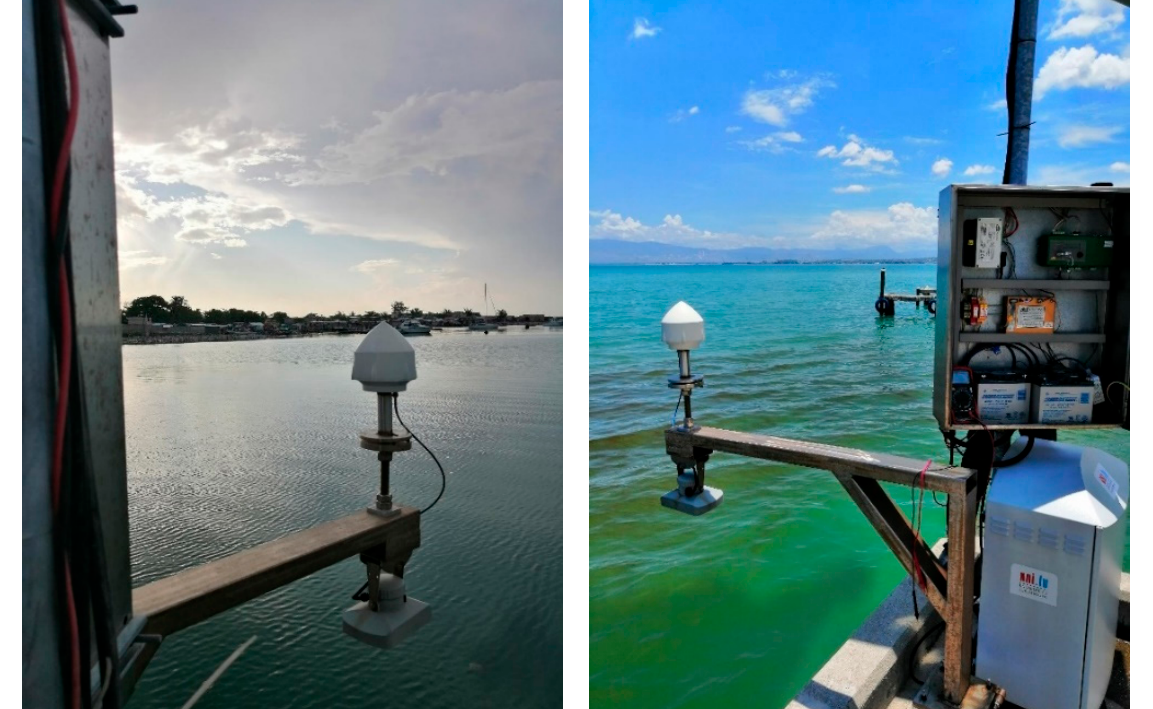
Figure 1. Tide gauge station at the Haiti Coast Guard Base in Port-au-Prince in the northwest (left panel) and northeast (right panel) directions.